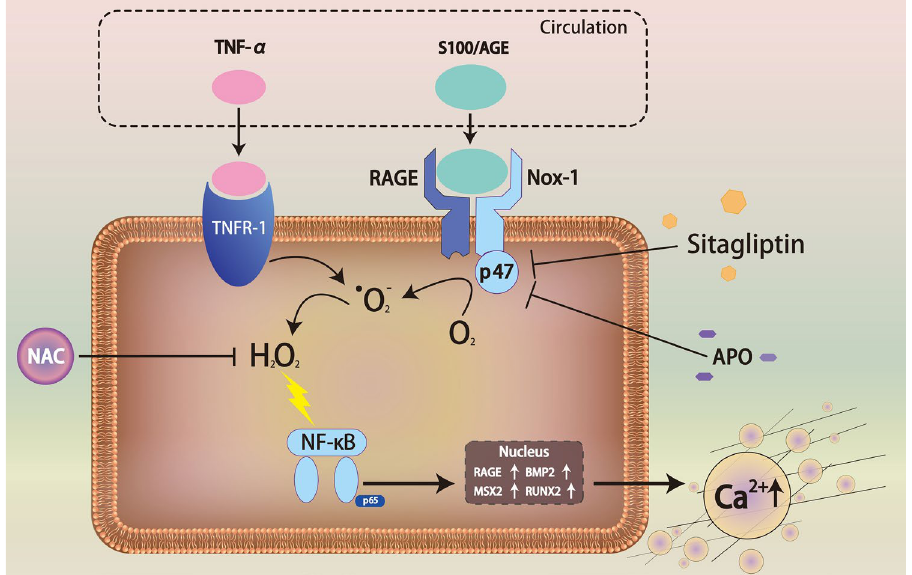
Figure 6. The proposed scheme of sitagliptin attenuates TNF-α + S100A12-induced VSMC calcification through inhibition of RAGE-Nox pathways. TNF-α enhances RAGE accumulation and activation by binding to the RAGE ligand, S100A12. S100A12 interacts with Nox1 NADPH oxidase to promote osteochondrogenic genes expression and calcium deposition in VSMCs via oxidative stress signaling. Sitagliptin reduces osteogenic mineralization by inhibiting the activation of NADPH oxidase and ROS